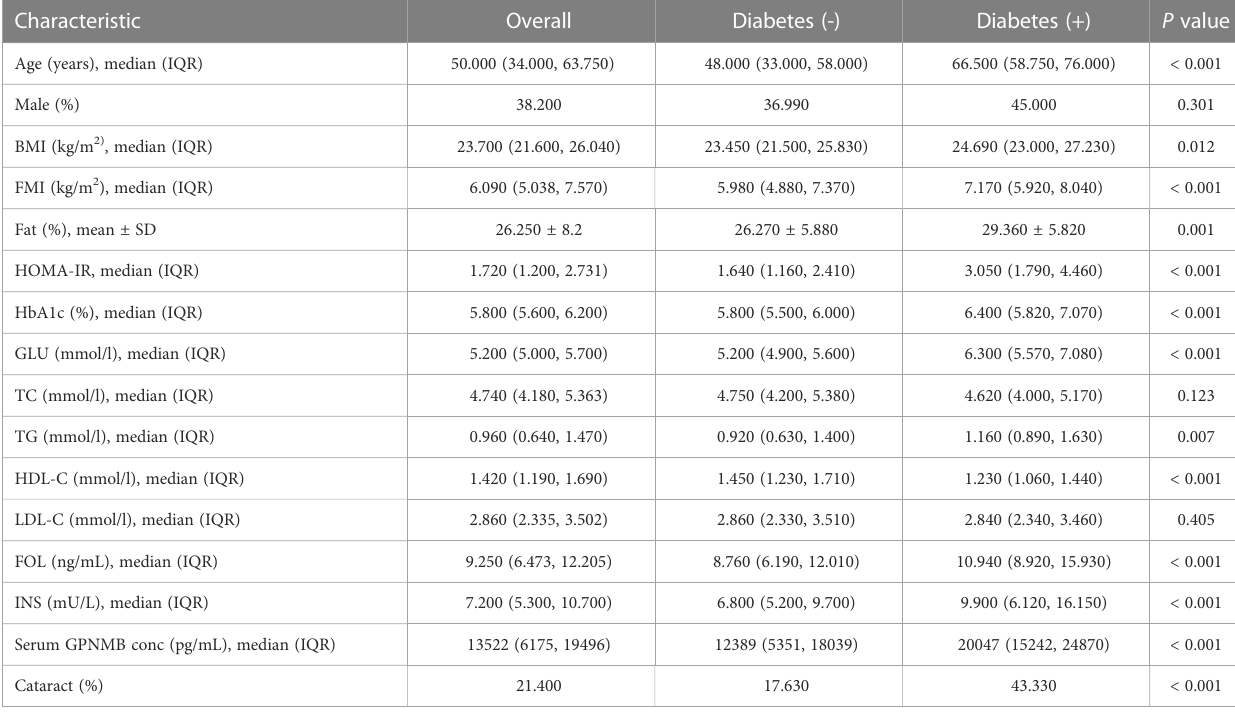
TABLE 1 Clinical and biochemical characteristics of study participants classi fi ed according to diabetes.